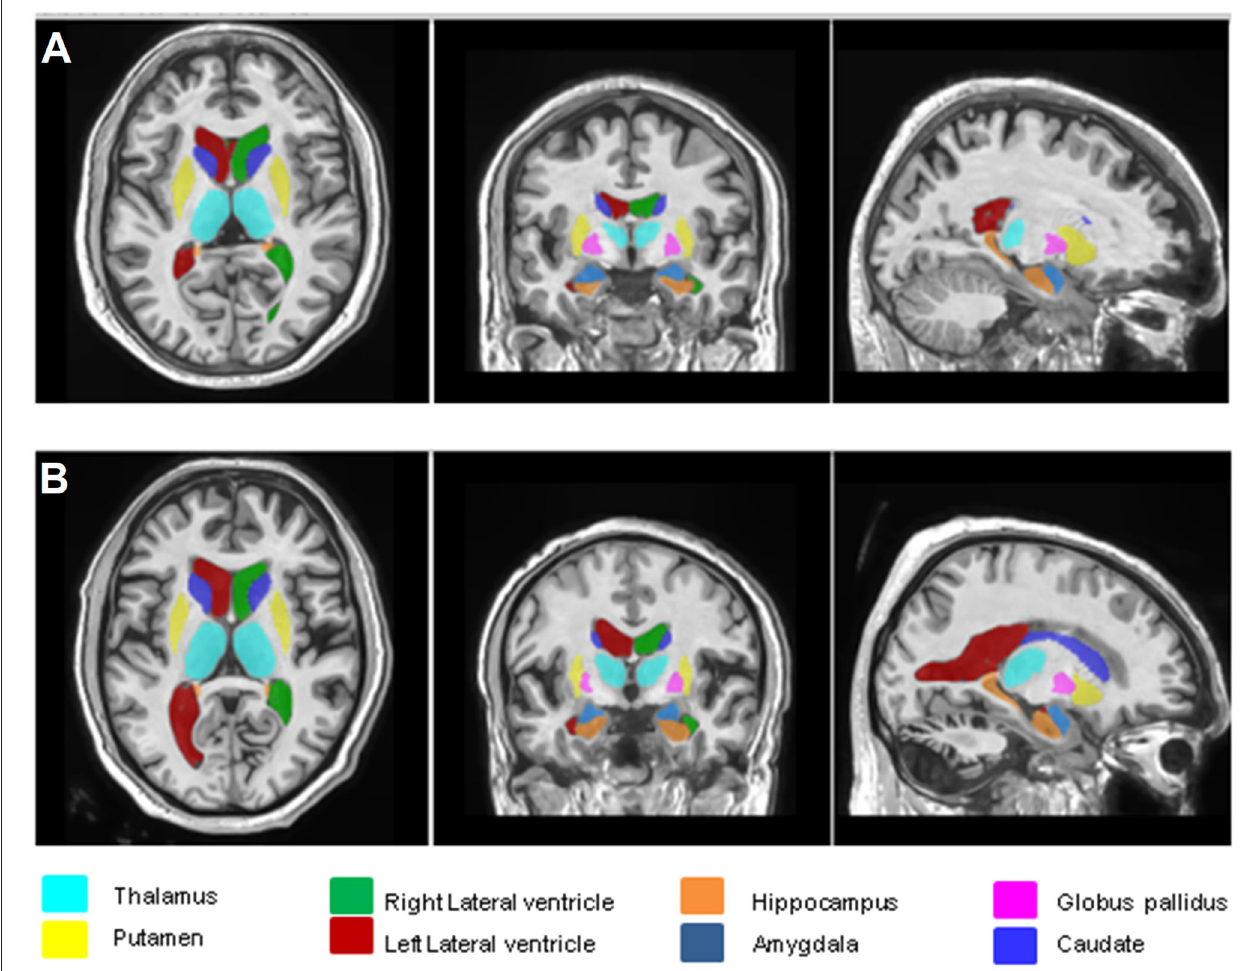
FIGURE 1 | Representative volBrain images of brain and sub-parts obtained from a healthy control (male, 44 years old) (A) and a patient with gluten ataxia (male, 55 years old) (B) .